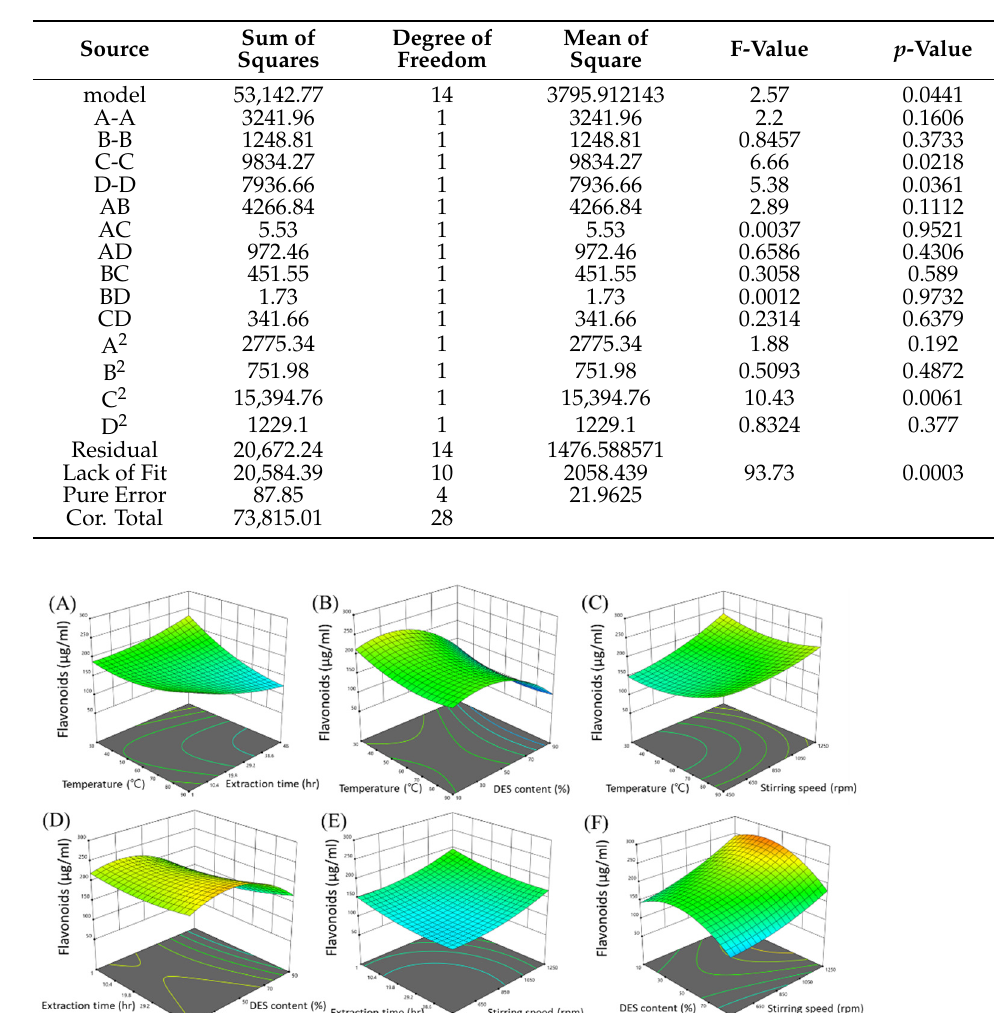
Table 3. ANOVA statistical results.